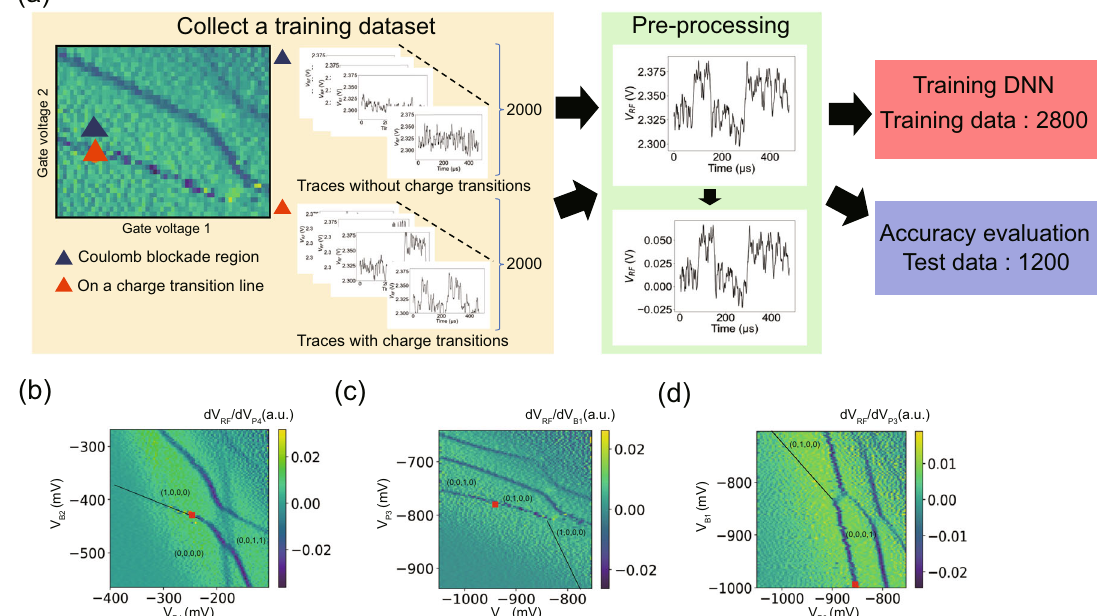
Fig. 3 The training procedure in experiments. a Schematic of the procedure for collecting and pre-processing the dataset for training. Each single-shot data is pre-processed by subtracting the mean value of the traces measured at a condition without charge transition events to remove the offset amplitude of charge transition signals. Then, 2800 pre-processed traces, which have the standardized voltage shift features associated with charge transition events and noises, are used to train the DNN classi fi er. Next, 1200 traces are used to evaluate the classi fi cation accuracy. The stability diagrams are used to collect the traces in Dot1 ( b ), Dot3 ( c ), and Dot4 ( d ). The red squares show the position for collecting the traces with charge transition events.